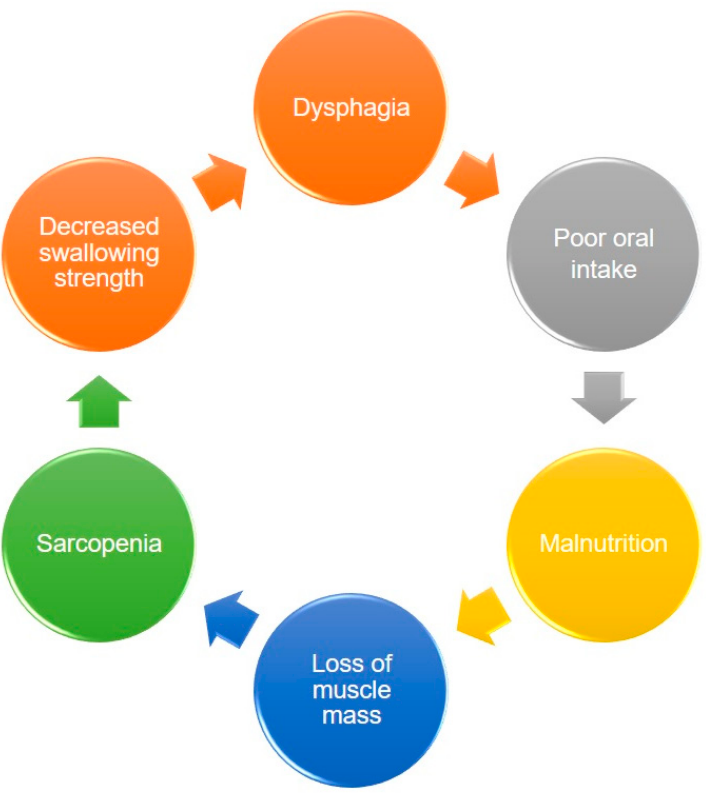
Figure 1. The vicious circle between dysphagia, malnutrition, and sarcopenia.